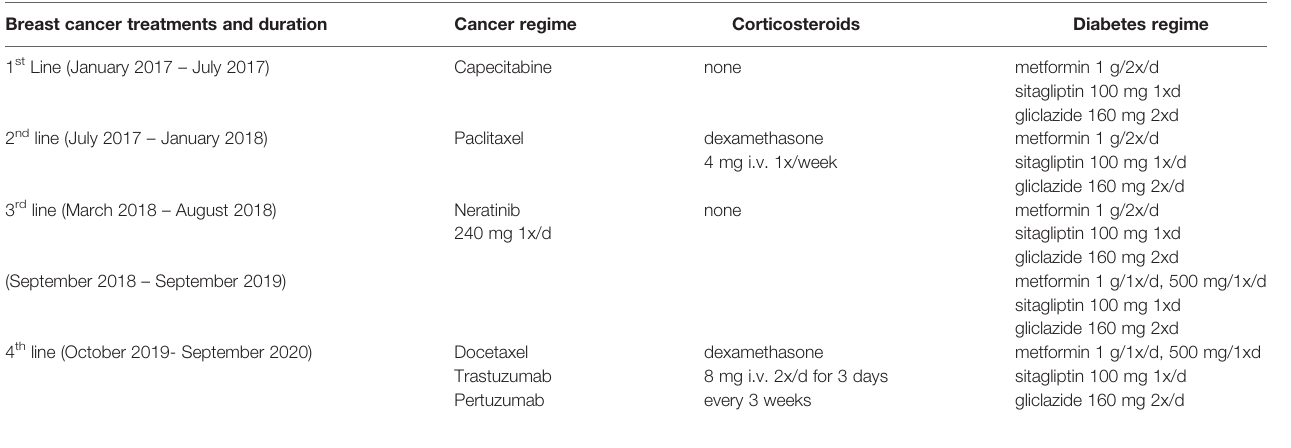
TABLE 1 | Lines of systemic anticancer and diabetes therapy received. Breast cancer treatments and